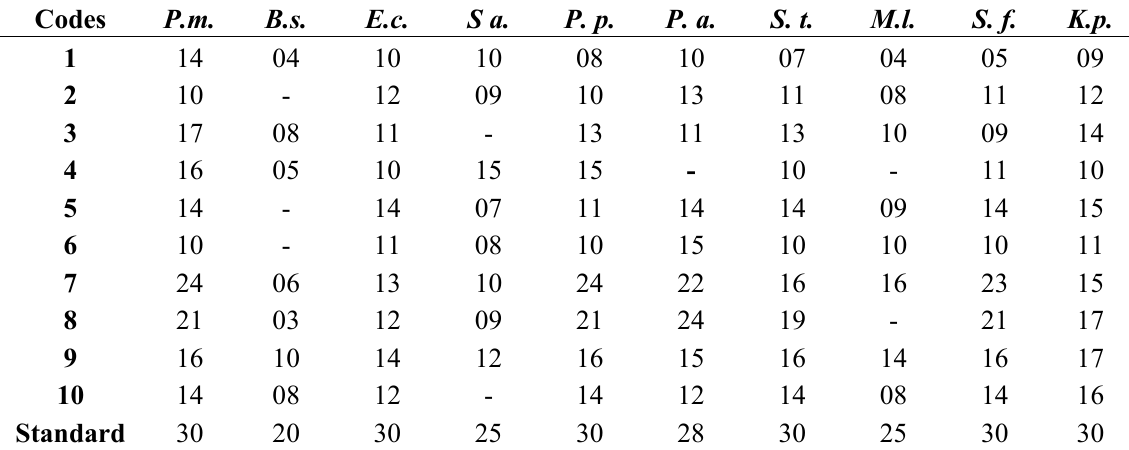
Table 2. Antibacterial bioassay screening of tertiary alcohols 1-10 .